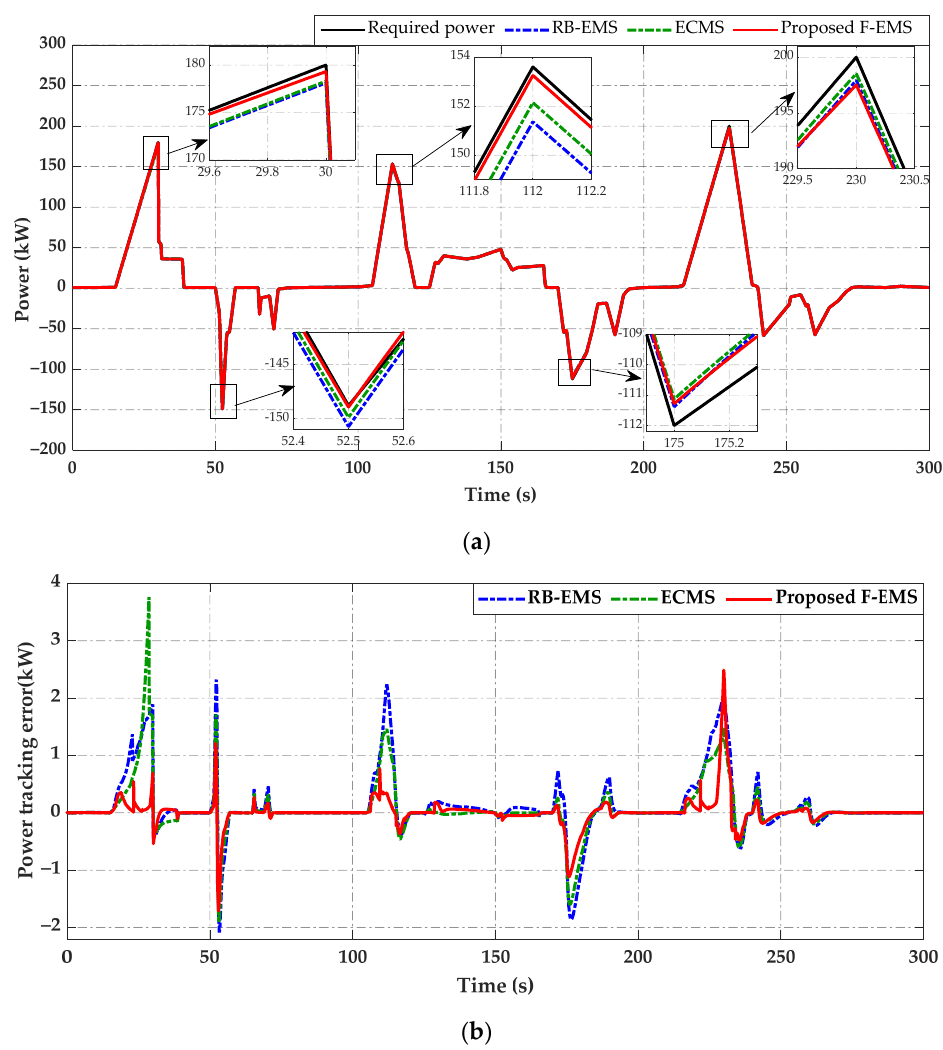
Figure 9. The comparison power released of load. ( a ) The power released for the hybrid tramway system from three strategies; ( b ) The comparison of power tracking error. Table 4. BAT